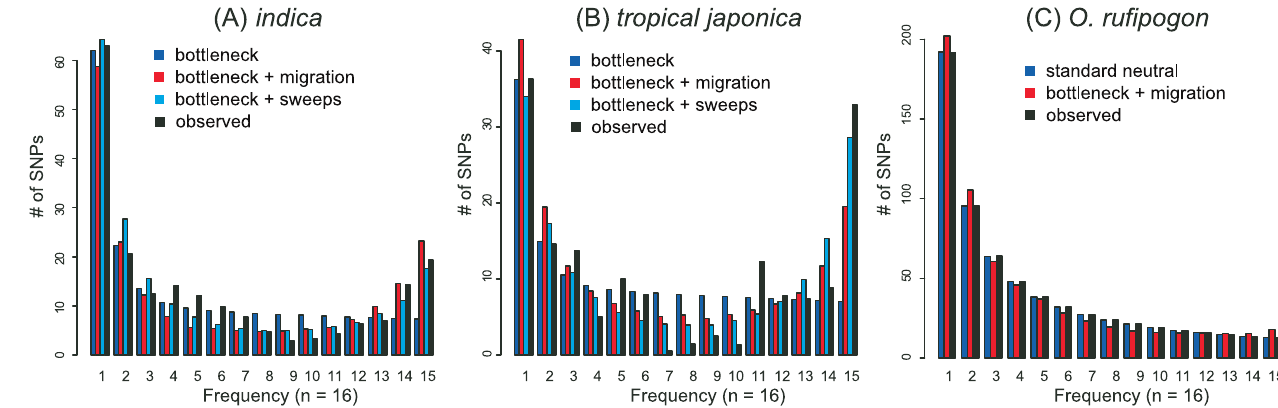
Figure 4. Observed and Expected Derived Site-Frequency Spectra under Various Models The observed derived site-frequency spectrum for (A) indica and (B) tropical japonica , along with the expected site-frequency spectrum under the simple bottleneck, bottleneck plus migration demography, and bottleneck plus sweeps models. (C) Observed site-frequency spectrum for O . rufipogon and expected frequencies using a standard neutral model and a bottleneck plus migration model.